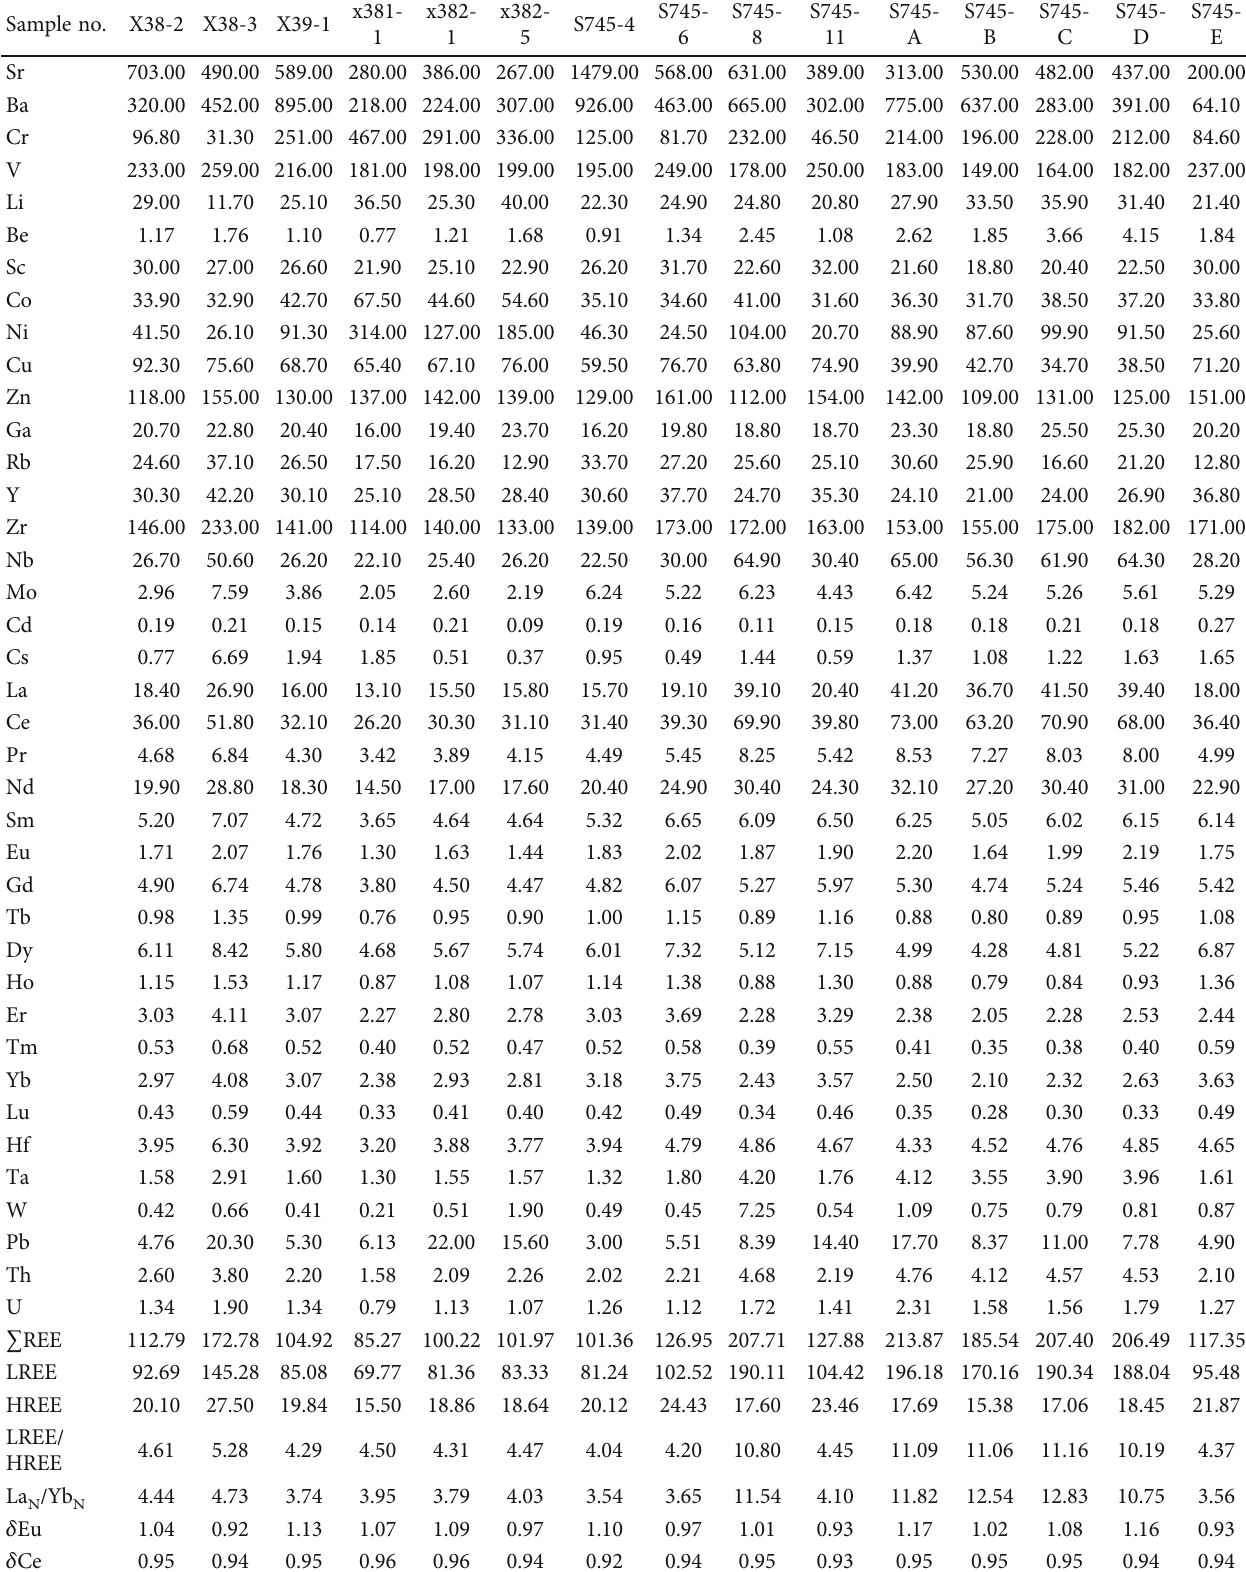
Table 2: Trace element (ppm) compositions for Paleogene igneous rocks in Huimin